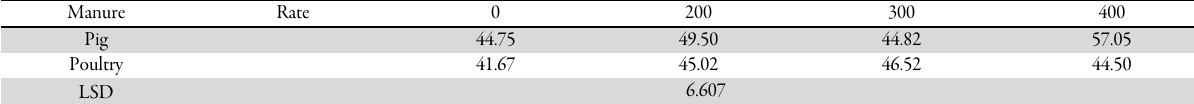
NS= Not significant Table 4. Interaction between types and rates of manure (g pot- 1 ) on plant height (cm) of tiger nut at 7 WAP. Values are a mean of 5 plants Manure